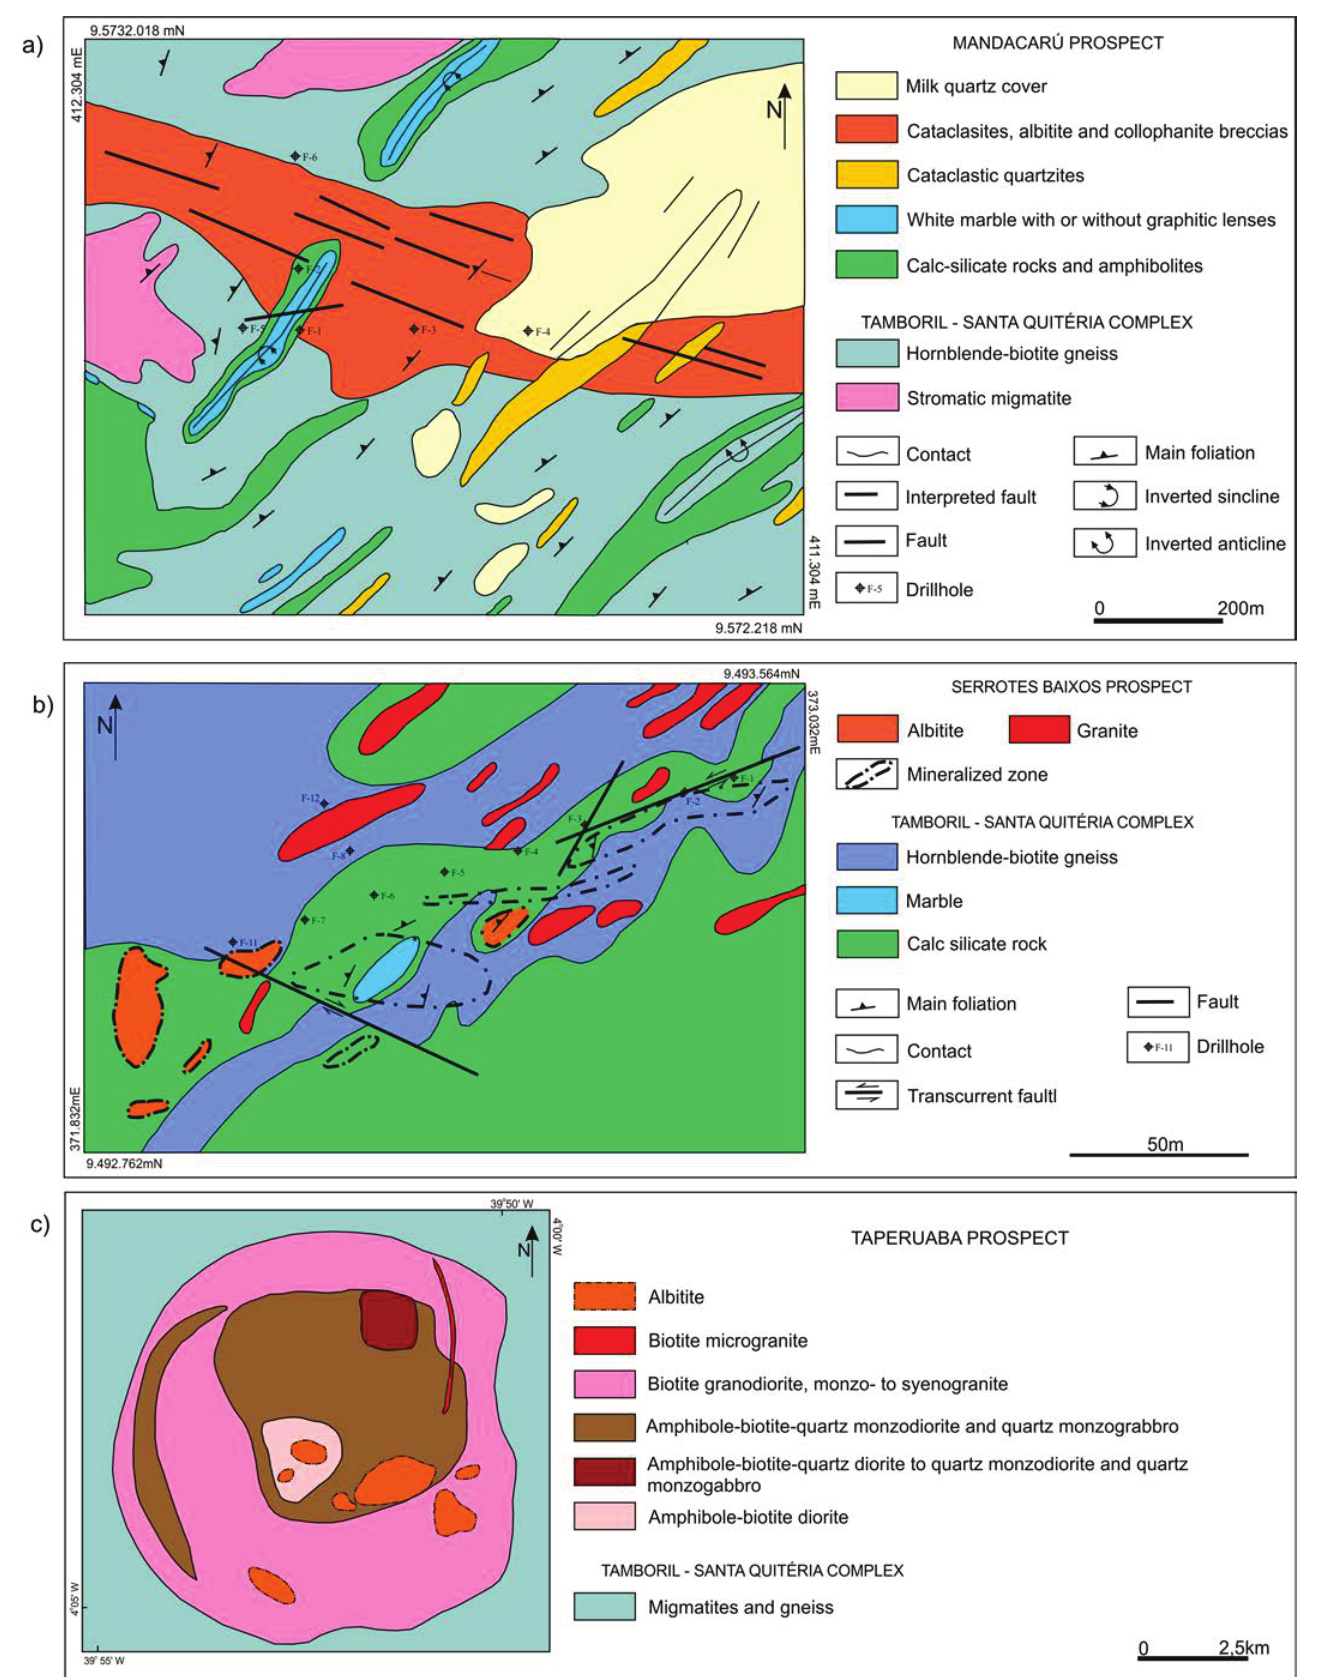
Figure 4 - Geological sketch maps of the main prospects in the Ceará Central domain: a) Mandacarú (Compiled from Leal et al. 1984); b) Serrotes Baixos (Compiled from Favali et al. 1984); and c) Taberuaba (Compiled from Castro et al.